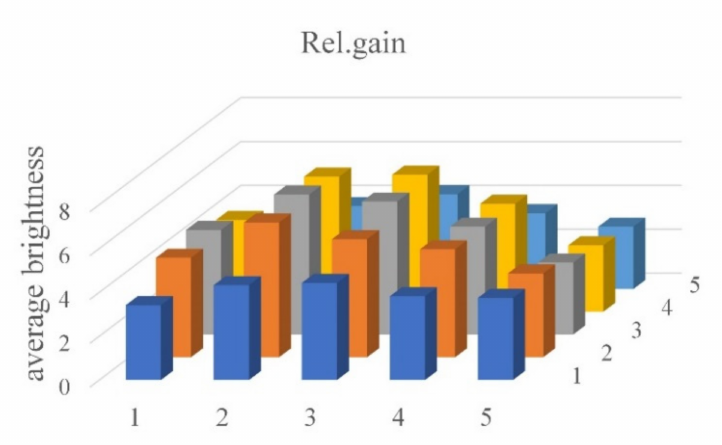
Figure 12. Average brightness of the tubes with: ( a ) FAM; ( b ) DDW.